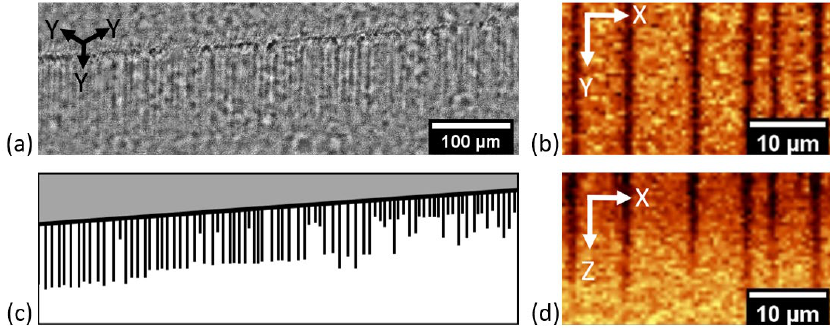
Figure 8. Quasi-periodic structure of stripe domains growing during polarization reversal by series of short rectangular pulses of low field from a flat domain wall created in high field. ( a ) Optical image in transmitted light. Images obtained by CRM method: ( b ) in polar XY plane, ( d ) in XZ plane. ( c ) Schematic representation of quasi-periodic structure.